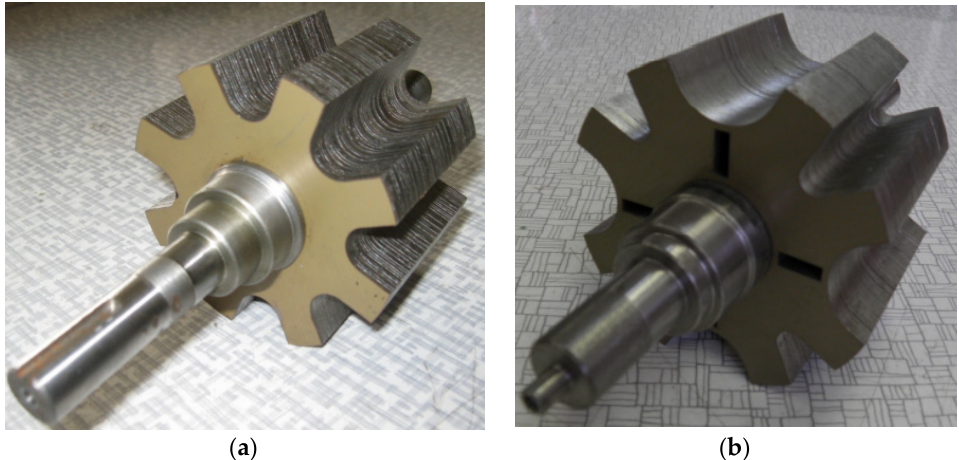
Figure 10. The appearance of the tested 10/8 straight poles switched reluctance motors rotors: ( a ) symmetrical; ( b ) asymmetrical.